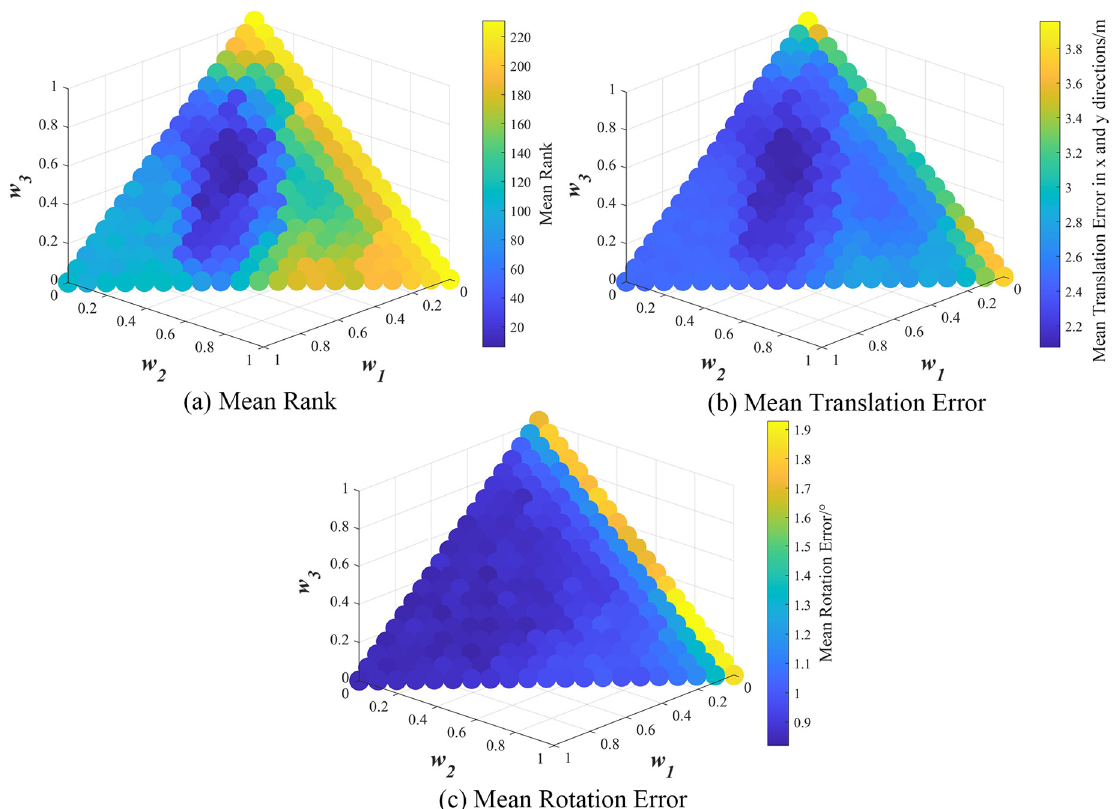
Figure 11. The registration result of all groups of weights in the fine registration.